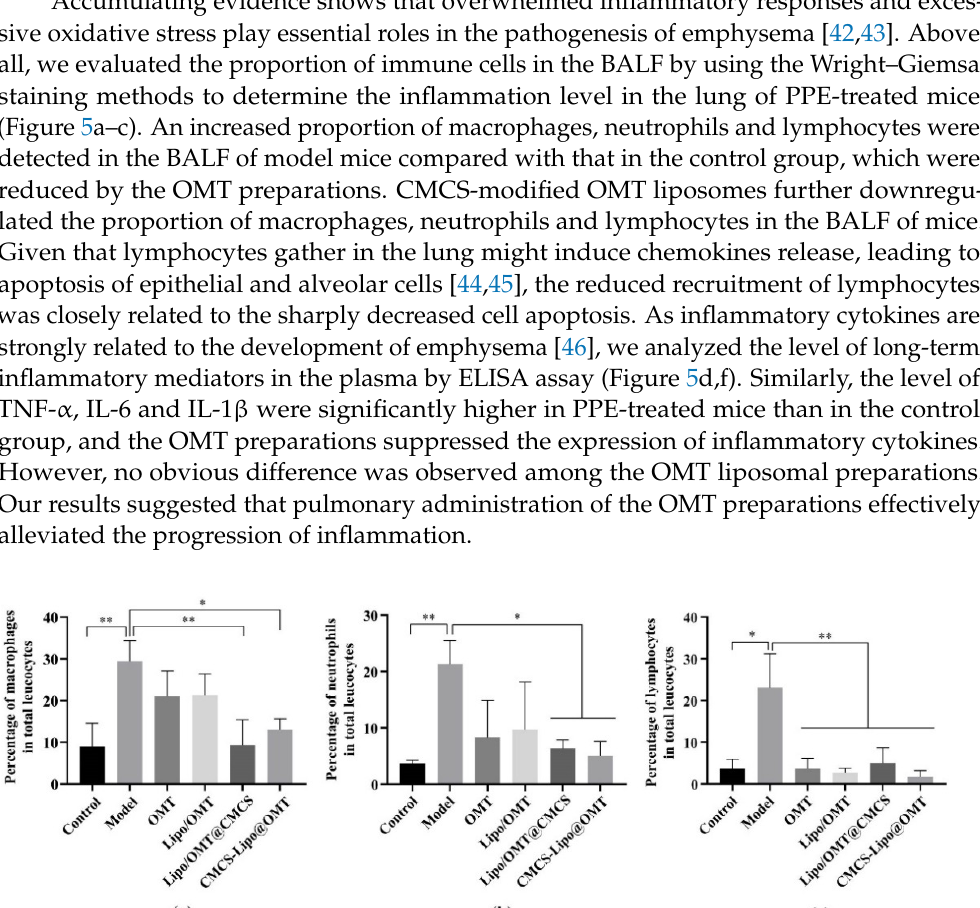
Figure 5. Effect of OMT and its liposomal preparations on the inflammation and oxidation stress in PPE-induced emphysema mice. The percentage of ( a ) macrophages, ( b ) neutrophils and ( c ) lympho- cytes in total leucocytes of BALF. The level of ( d ) TNF- α , ( e ) IL-1 β and ( f ) IL-6. The levels of ( g ) MDA, ( h ) SOD and ( i ) CAT. ( a – c ) Data represent the means ± SD ( n = 3).( d – i ) Data are expressed as mean ± SD ( n = 5). * p < 0.05, ** p < 0.01. In our study, Nrf2, HO-1 and I κ B α were markedly reduced and phosphorylated NF- κ B p65 was significantly elevated in the PPE-stimulated emphysema model in comparison with that of the control group (Figure 6). Pulmonary administration of OMT and Lipo/OMT slightly increased the expression of Nrf2, HO-1 and I κ B α , however, there was no significant difference compared with the model group. CMCS-modified liposomes sig- nificantly improved the expression of Nrf2, HO-1 and I κ B α , especially for the CMCS- Lipo/OMT group, regardless of the similar levels of phosphorylated NF- κ B p65 in the OMT liposomal preparations. These results indicated that OMT may play an important role by inhibiting the dissociation of NF- κ B P65 and I κ B α and exerting antioxidative ef- fects via increasing the expression of Nrf2 and its downstream. In summary, pulmonary administration of OMT could exert its ameliorative effects in emphysema mice by regulating NF- κ B p65 and Nrf2, which suppressed the inflamma- tory reactions and oxidative stress. Its anti-inflammatory and antioxidant effects were in- creased after liposome encapsulation and CMCS modification. Moreover, covalent